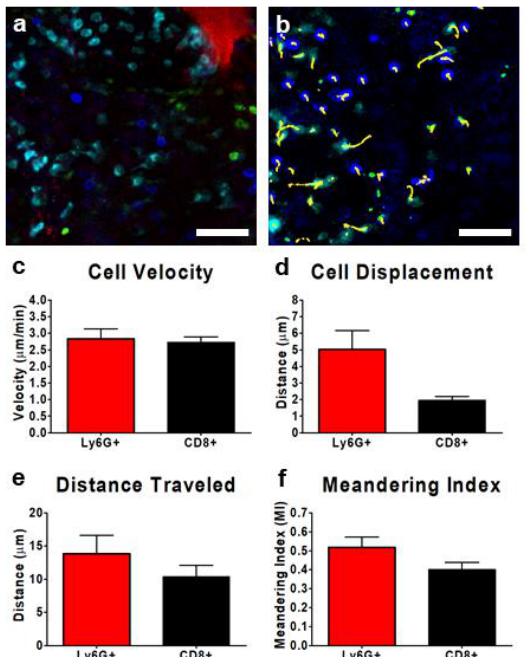
Figure 5. Characterization of interstitial leukocyte behavior within the TME of a subcutaneous CD-26 tumor. Representative resonant scanning confocal images of the tumor interstitium ( a , b ); tumor cells (red), neutrophils (cyan; BV421-conjugated Ly6G), and CD8+ leukocytes (blue; eFluor 660-conjugated anti-CD8) ( a , b ). Cell movement was tracked over a 10 min imaging window (yellow tracks) for at least three separate fields of view and quantified ( b ). Leukocyte velocity ( c ), displacement from initial starting point ( d ), distance travelled ( e ), and meandering index ( f ) were measured for each of the neutrophils (red) and CD8+ T cells (black); n = 3 animals. Between 8 and 50 Ly6G+ cells were traced in each field of view, whereas only 0–4 CD8+ cells were visualized per field of view. Data displayed as the mean ± SEM. The white scale bar represents 50 µ m. Images in ( a , b ) were captured using resonant scanning confocal